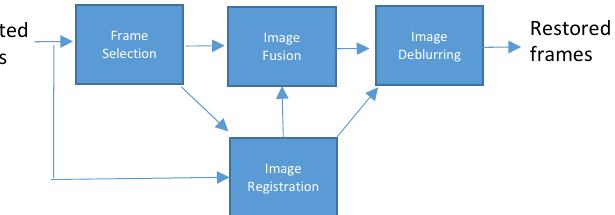
Figure 2. CLEAR architecture [11]. Frame selection generates lucky regions which are referring to image patches that are least affected by air turbulence. Details can be found in [11].